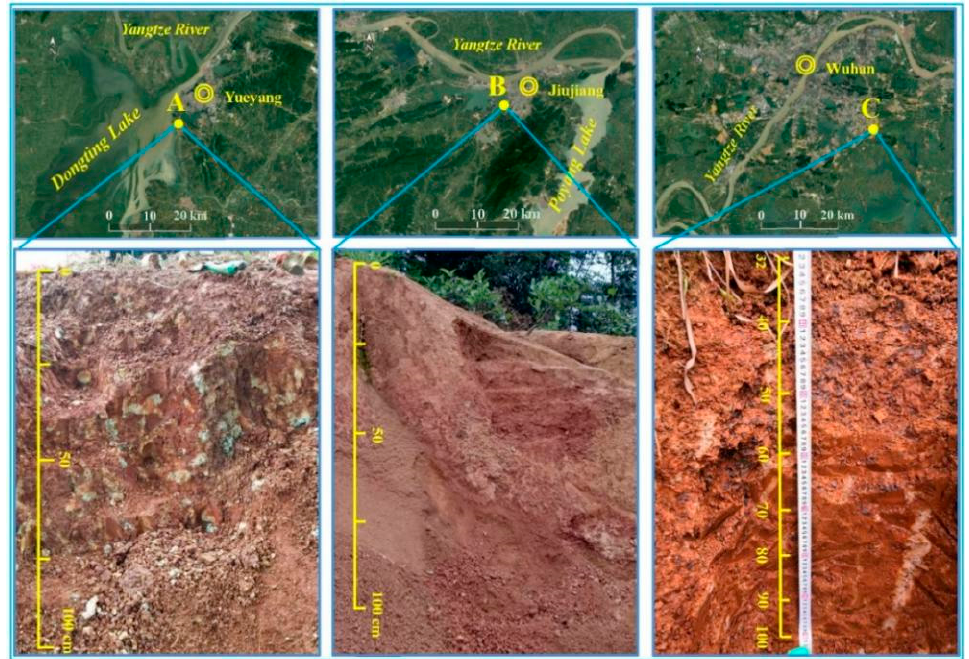
Figure 2. The locations of the sampled profiles of Yueyang (YE), Jiujiang (JU), and Wuhan (WH). (The A , B and C represent the location of YE, JU and WH profile, respectively.).